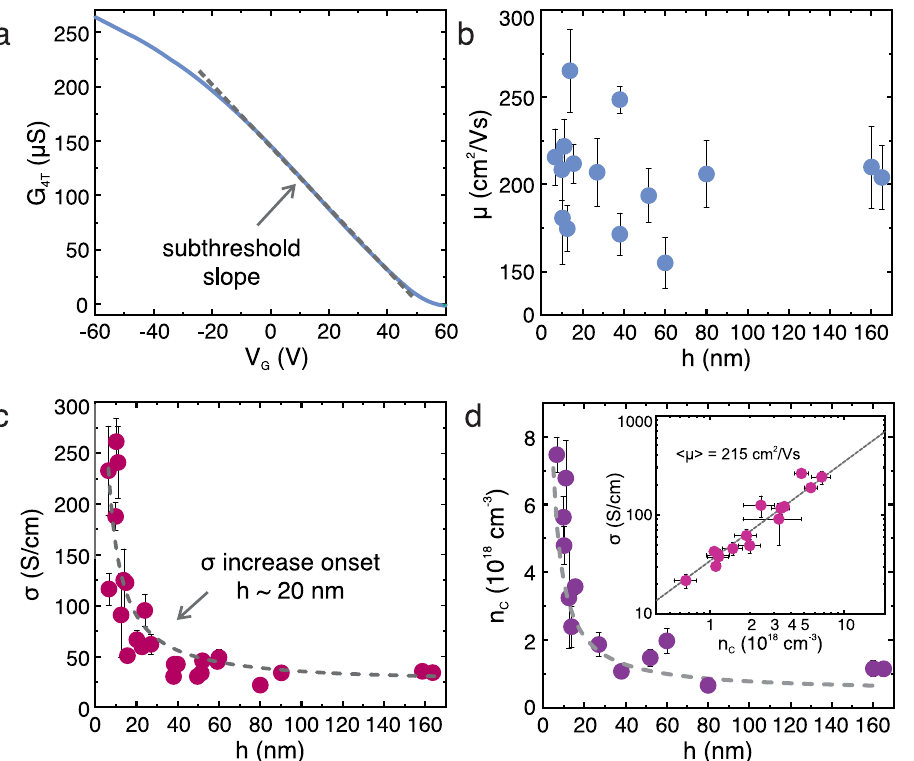
Fig. 2 Height-dependent electronic properties of BP fl akes at room temperature. a Representative four-point fi eld-effect characteristic of a BP fl ake showing unipolar p -type behaviour and weak on/off switch. The hole mobility was extracted from the linear part of the subthreshold slope (denoted in the graph by a dashed grey line). b Charge carrier mobility values are estimated based on the fi eld-effect characterisation. The mobility values do not show a height-dependent trend and show a few variations around 200 cm 2 /Vs, which fall within the range of the weakly developed in-plane anisotropy in charge transport at room temperature 11 . c Electrical conductivity and d charge carrier density show a steep increase for fl akes with a height below ca. 20 nm (dashed lines as a guide to the eye), whereas, in thicker fl akes, the values remain approximately constant. Inset d Linear dependence between conductivity and carrier density implies a height-independent average charge carrier mobility of ca . 215 cm 2 /Vs. Error bars result from data acquisition and error propagation in data